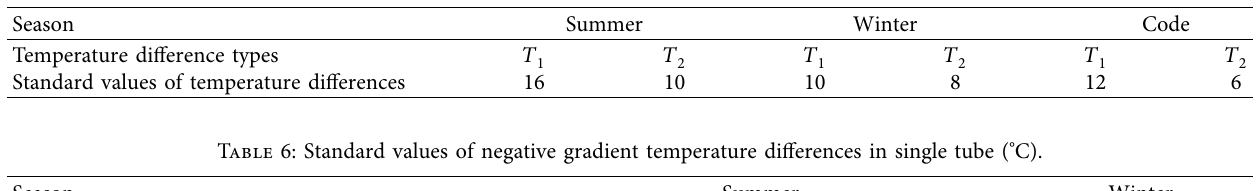
Table 5: Standard values of gradient temperature differences in single tube ( °